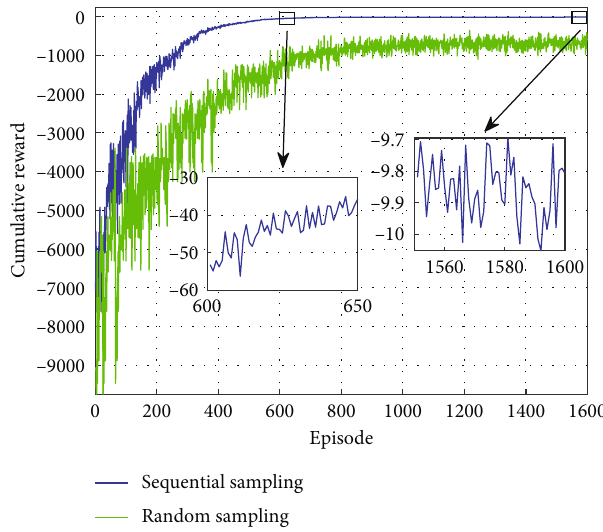
Figure 9: Episode cumulative reward change curve. Table 3: Flight state at three di ff erent feature